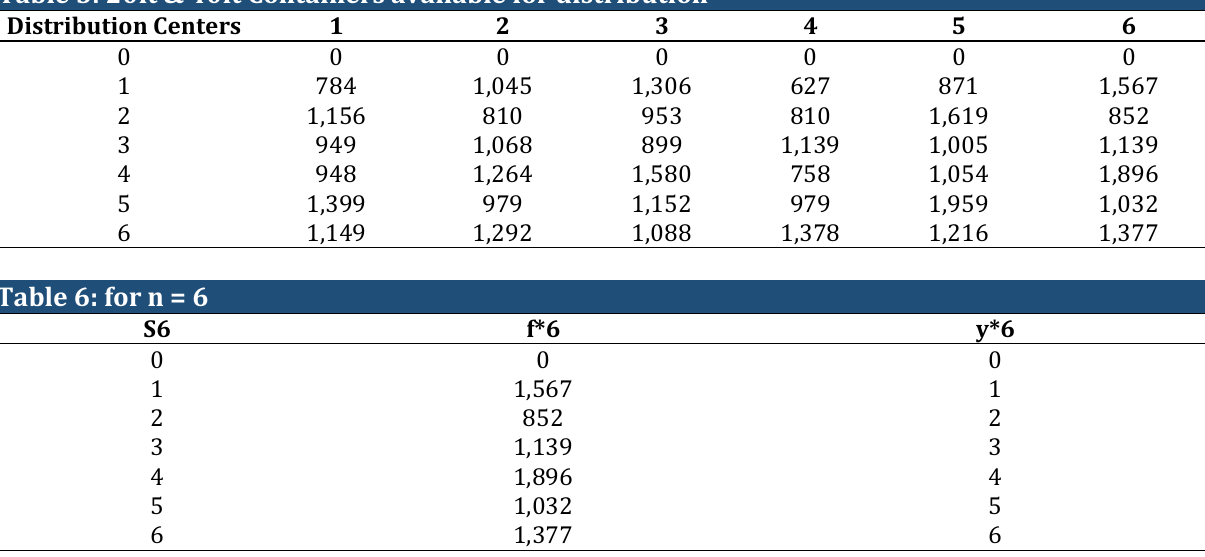
Table 5: 20ft & 40ft Containers available for distribution Distribution Centers